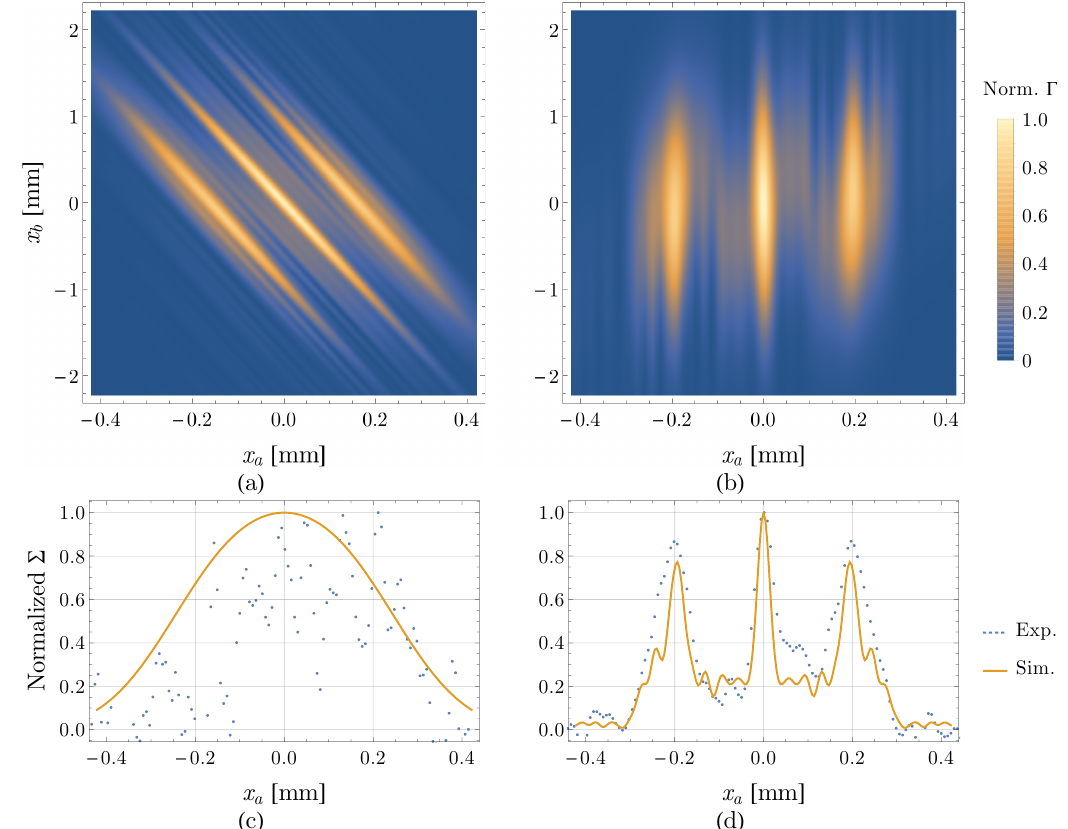
Figure 3. ( a ) Theoretical prediction of the correlation between the intensity fluctuations retrieved by D a and D b , as given by both Equation (2) and, in the geometrical optics limit, Equation (10). Plots have been obtained by considering the setup reported in Figure 1, with the parameters characterizing the experimental setup, in the case of a triple slit of width a and center-to-center distance d = 2 a as a transmissive object; ( b ) application to the data in panel ( a ) of the refocusing algorithm of Equation (11); ( c , d ) the solid (yellow) lines represent theoretical predictions obtained by integration of the data of panel ( a , b ), respectively, over the detector D b . In ( c ), we report the ghost image, while ( d ) shows the CPI refocused image, as obtained by Equation (12). The (blue) points represent experimental data obtained in the setup that will be discussed in Section 3 after integration of the two-dimensional images over the coordinate y a . Reproduced with the permission from [42], copyright American Physical Society,